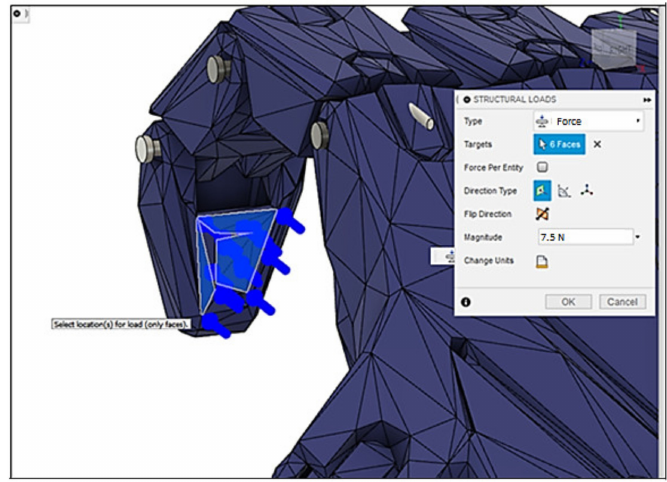
Figure 12. Allocation of acting